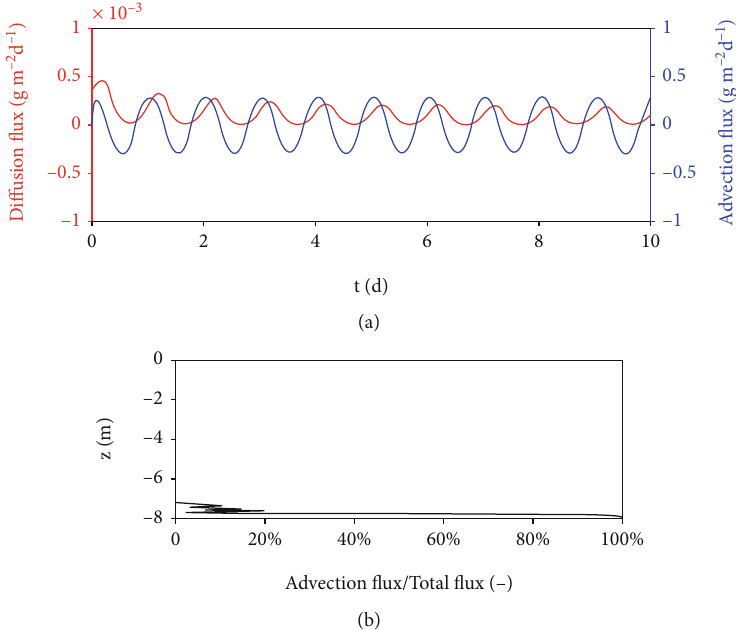
Figure 6: Fluxes caused by di ff usion and advection at x = 10m , where T = 1d and A = 0 : 2m : (a) fl uxes during the initial 10 days at z = 8 m , and (b) the proportion of fi ve-day averaged advection fl ux to the total mass fl ux under the dynamic equilibrium condition along the vertical